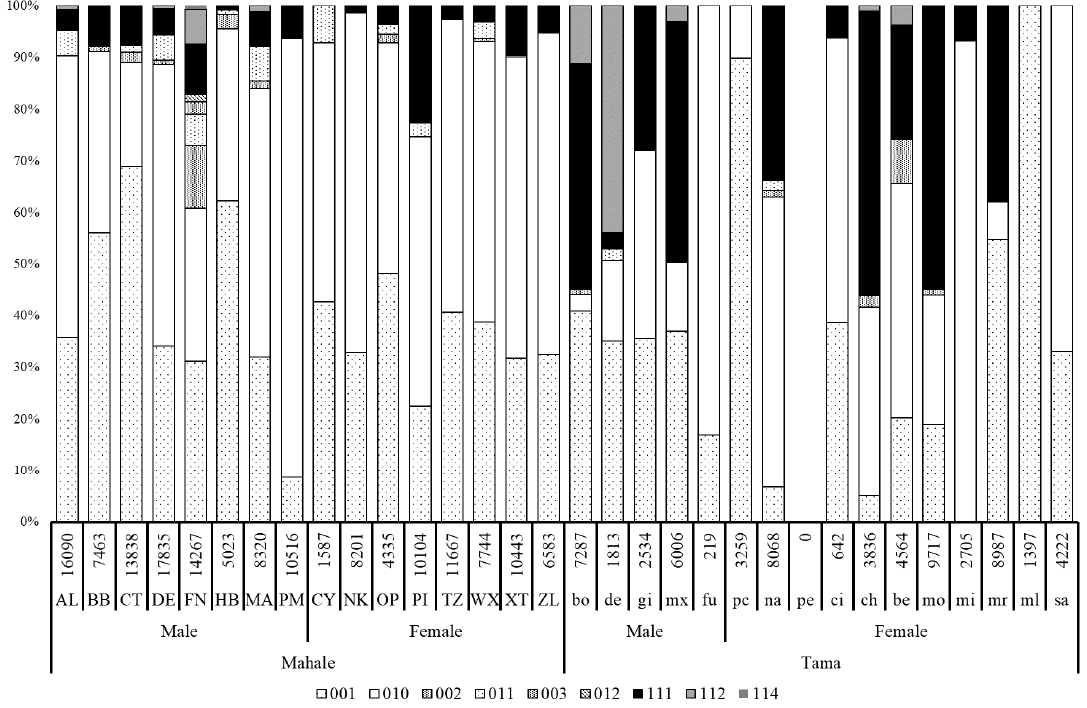
Figure 2. Percentage of time spent in each type of grooming clique for each individual in both groups. The numbers above the abbreviations of the focal individuals’ names indicate the total number of seconds that each individual participated in a social grooming interaction. Table 2. Types of grooming cliques during the study period. Black circles indicate the focal individual, white circles indicate the other individuals, → indicates who the grooming was directed toward, ↔ indicates mutual grooming, ○○ or ○○○ indicates two or three individuals simultaneously grooming a focal individual. The gray rows indicate mutual grooming.